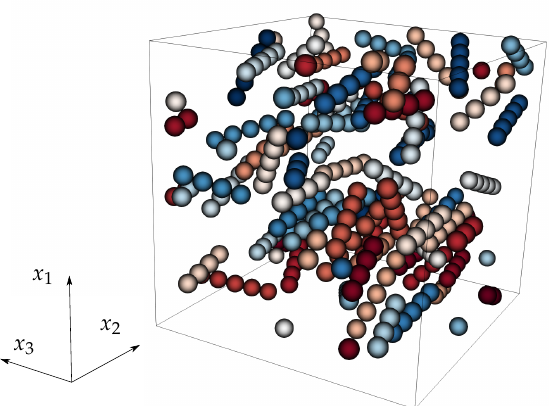
Figure 8. Snapshot of fibers at 10% fiber volume fraction after 30 strains. The colors are introduced to distinguish fiber particles and represent the particle ID.